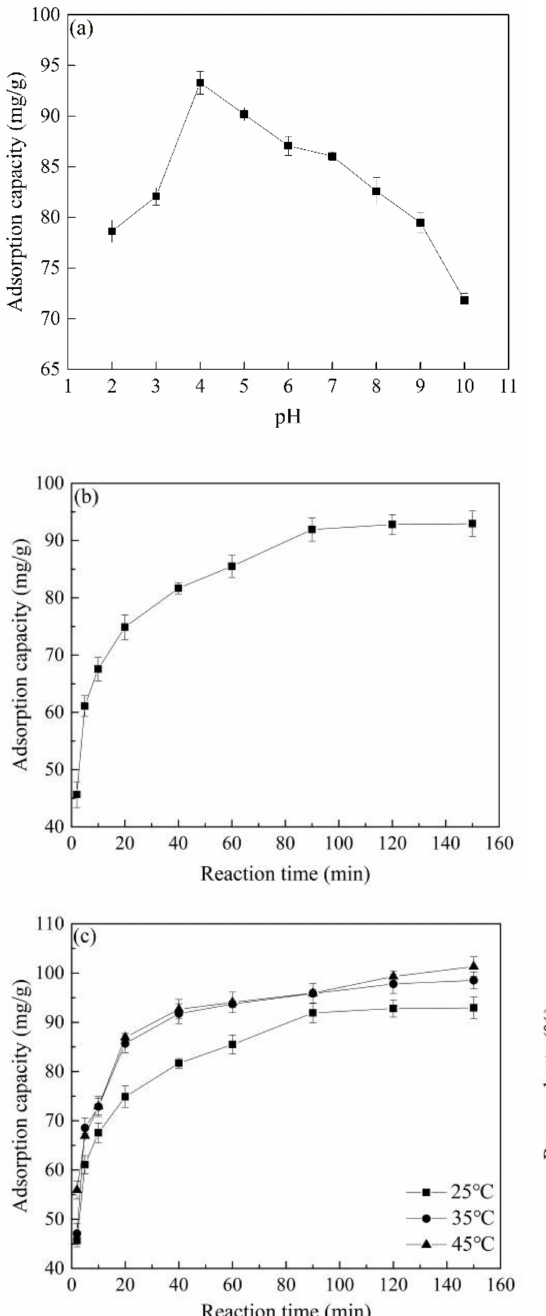
Figure 4. The effect of reaction conditions on the atrazine removal: ( a ) solution pH, ( b ) reaction time, ( c ) reaction temperature, ( d ) material